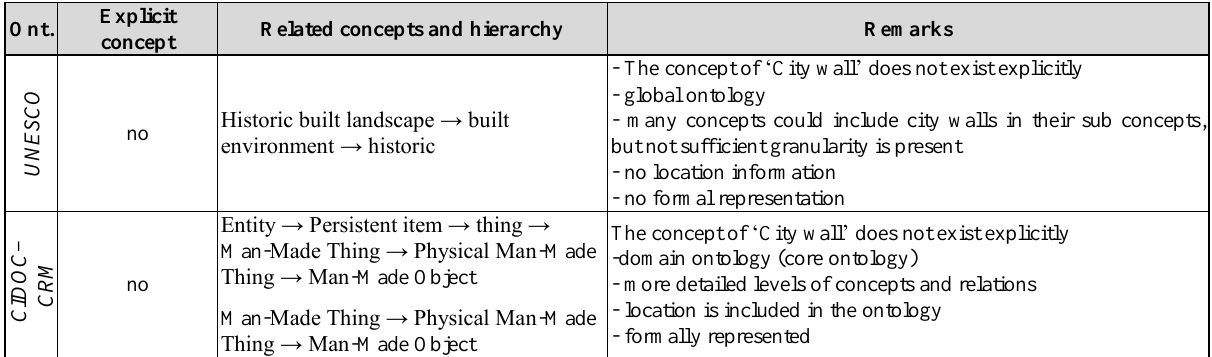
Table 1: Representation of the concept ‘City walls’ in different